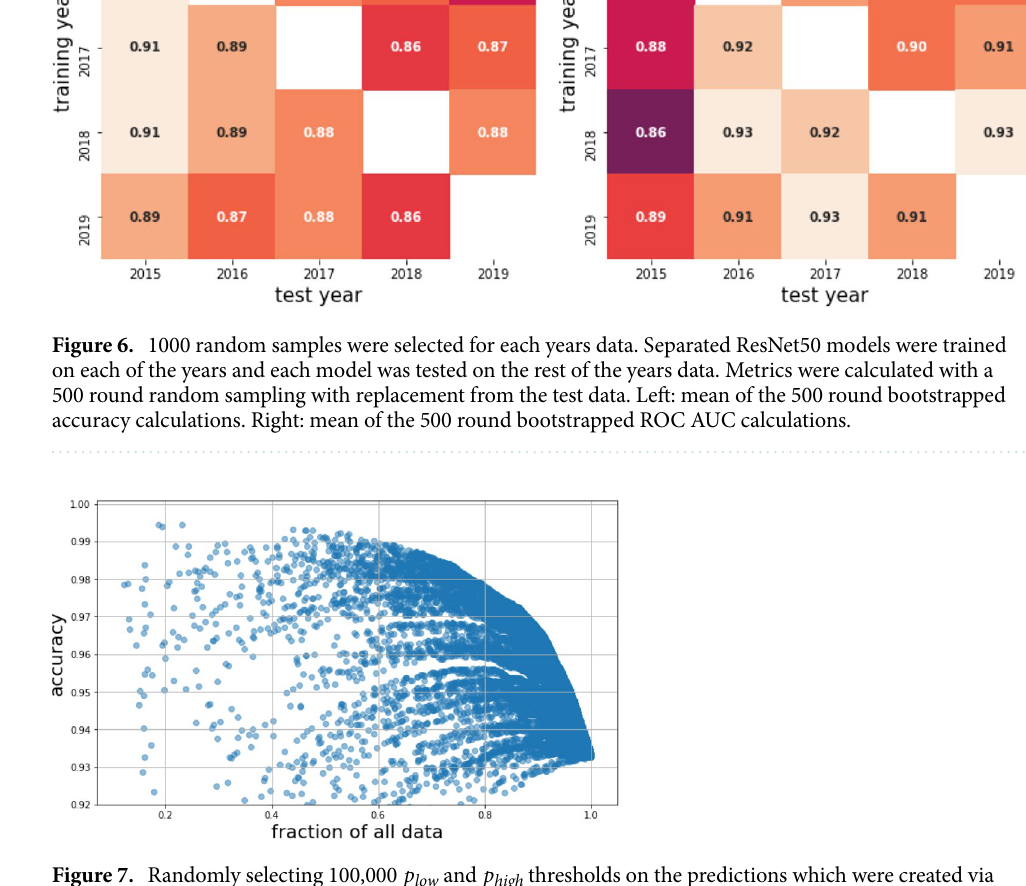
Figure 7. Randomly selecting 100,000 p low and p high thresholds on the predictions which were created via yearly cross-validation. Each time only samples were kept where the predicted probability were out of the [ p ; p ] interval. Each point shows the kept data fraction and the prediction accuracy. Varying the lower low high and upper predicted probability almost 98% of the images are correctly predicted while keeping 80% of all the